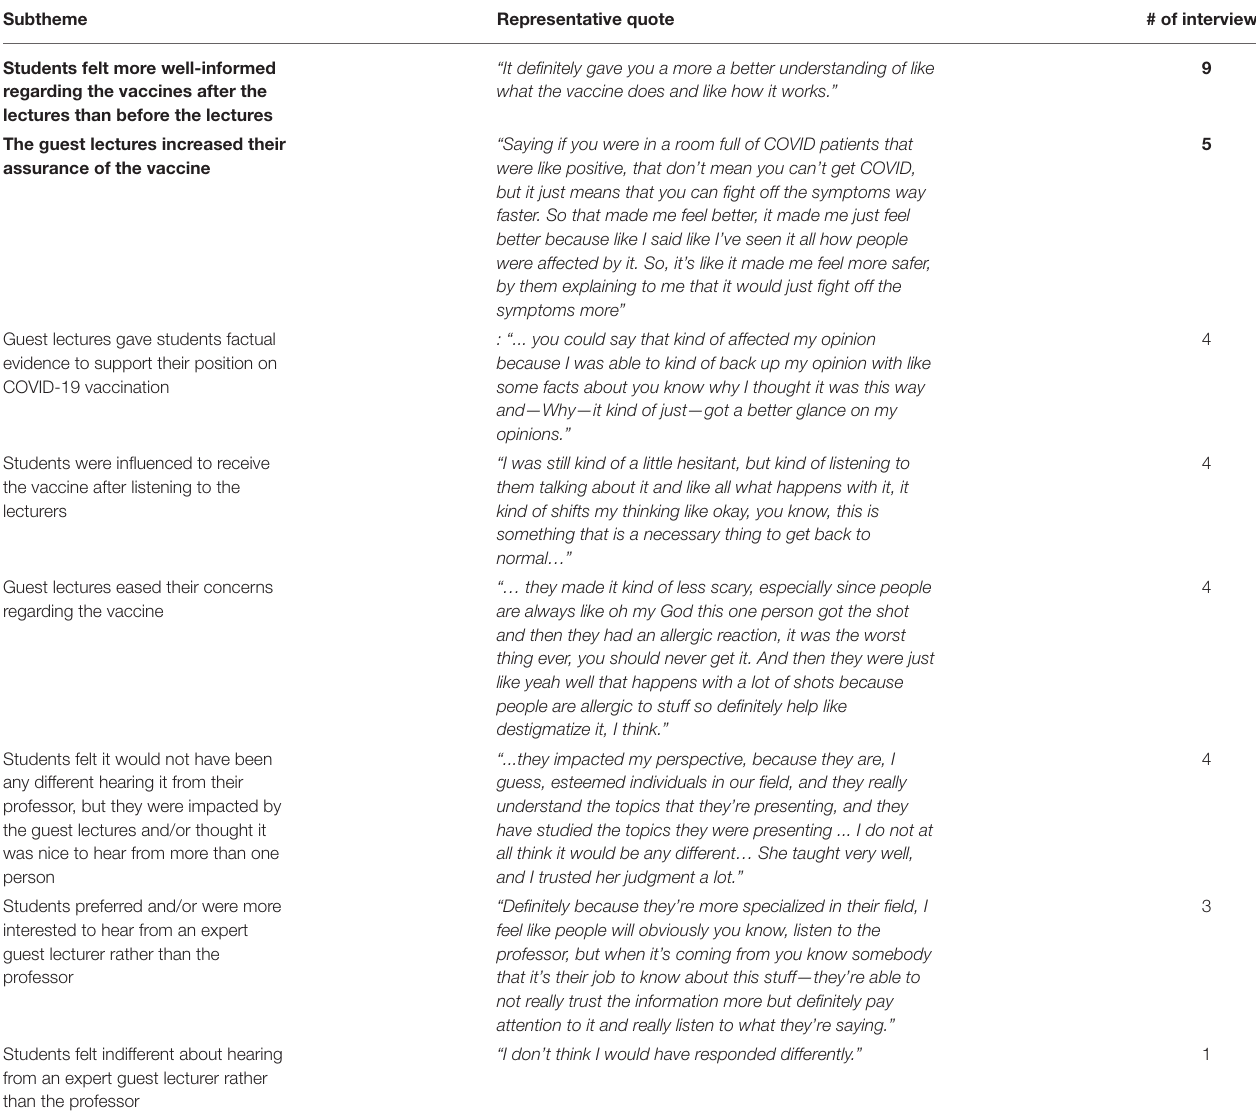
TABLE 1 | Interview codes related to guest